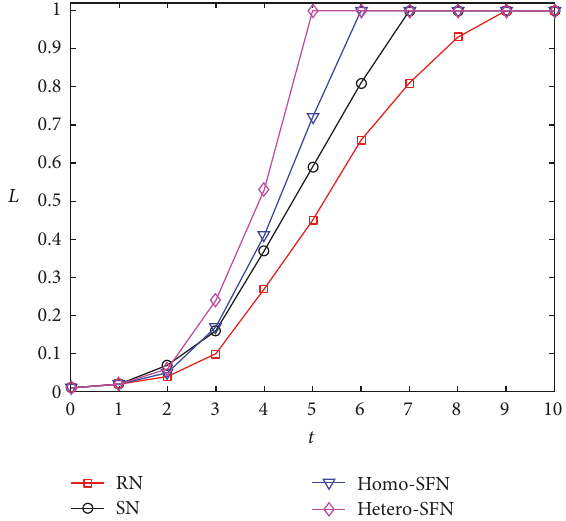
Figure 10: Cascading process under max-status attack (𝜀 = 0.6) .